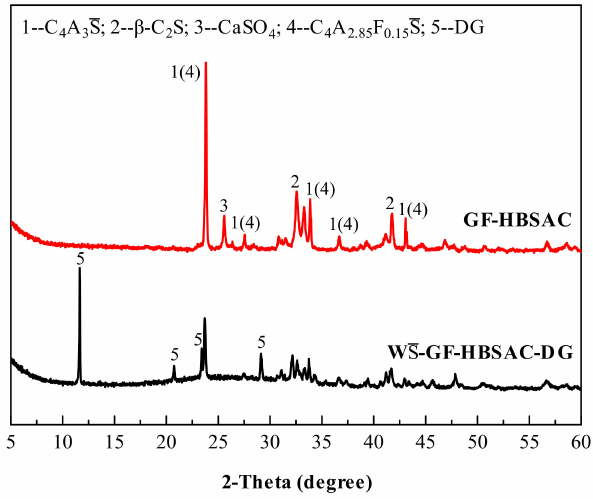
Figure 6. X-ray di ff raction (XRD) patterns of the Series GF-HBSAC-X cement.